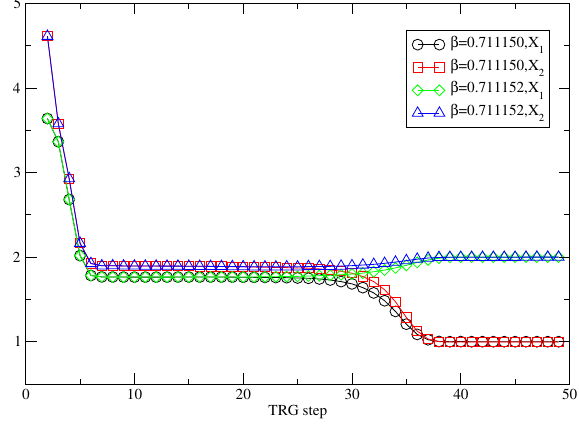
Table 1 . Fit results for the critical point (cid:12) c ( 1 ) and the critical exponent (cid:23) at N (cid:28) = 2 ; 3 ; 5. (cid:12) X 1 and (cid:12) X 2 c